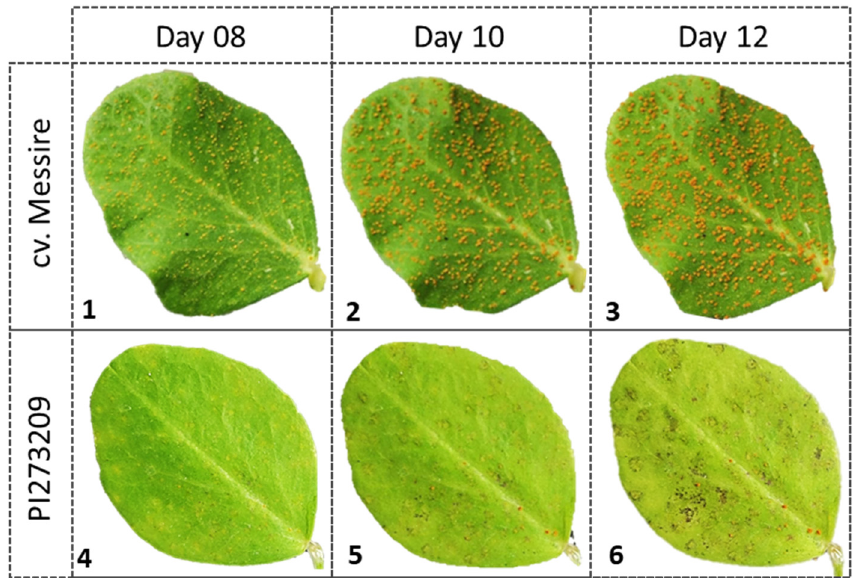
Figure 3. Different cells attacked by U. pisi colonies in PI273209 accession: ( a ) Epidermic tissue vis ‐ ualized with fluorescent blue filter at 48 h post inoculation showing a germinated urediospore (1), the stoma (2), and a dying epidermal cell (3); ( b ) Mesophyll tissue visualized with fluorescent green filter showing the substomatal space (1) and two dying mesophyll cells (2).